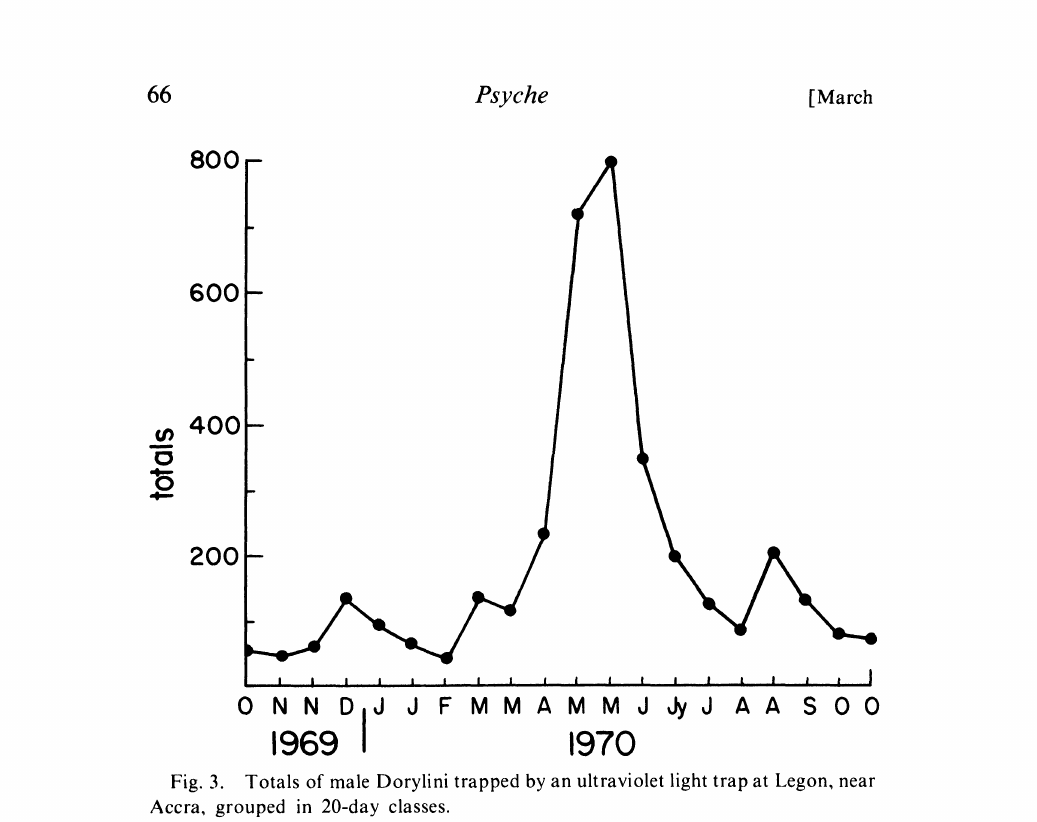
Fig. 3. Totals of male Dorylini trapped by an ultraviolet light trap at Legon, near Accra, grouped in 20-day